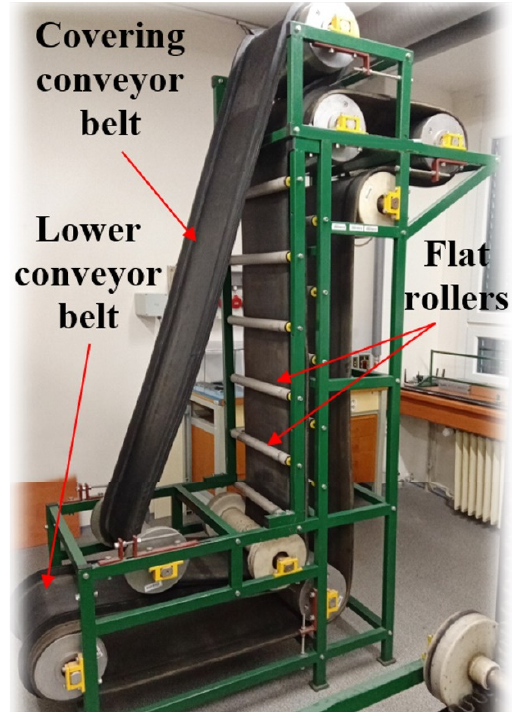
Figure 1. Sandwich belt